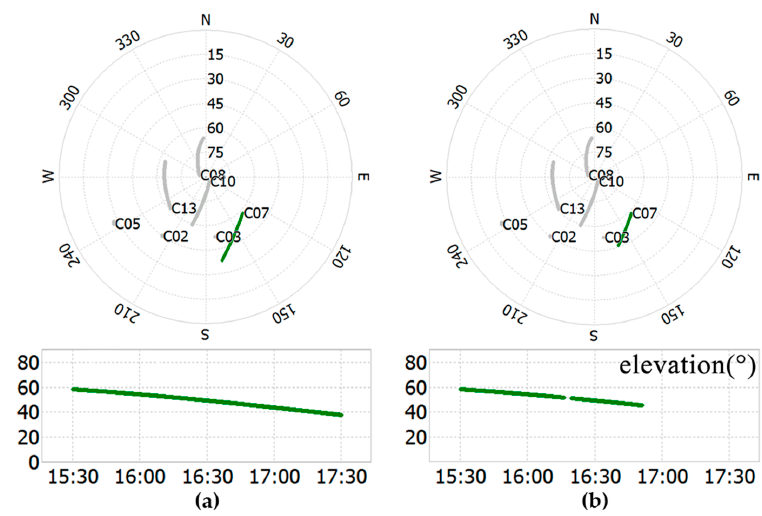
Figure 8. Sky view of points from 15:30 to 17:30 and the satellite elevation of C07: ( a ) reference point NQ01 and ( b ) rover point NQ02.